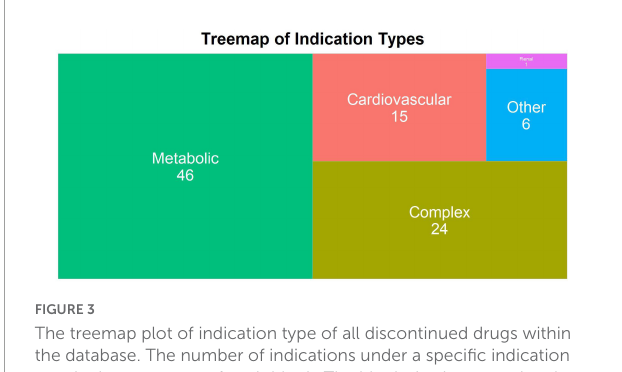
FIGURE3 The treemap plot of indication type of all discontinued drugs within the database. The number of indications under a specific indication type is shown on top of each block. The block size is proportional to the number.